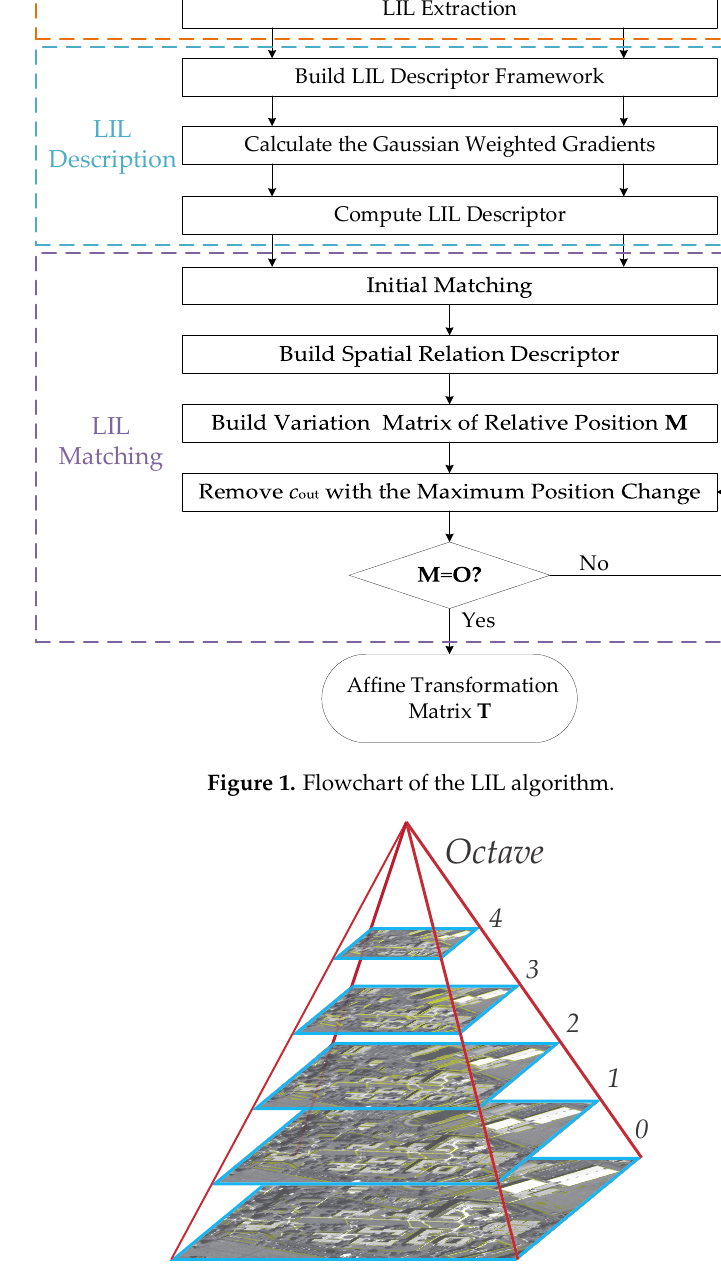
Figure 2. Multi-scale Gaussian pyramid.